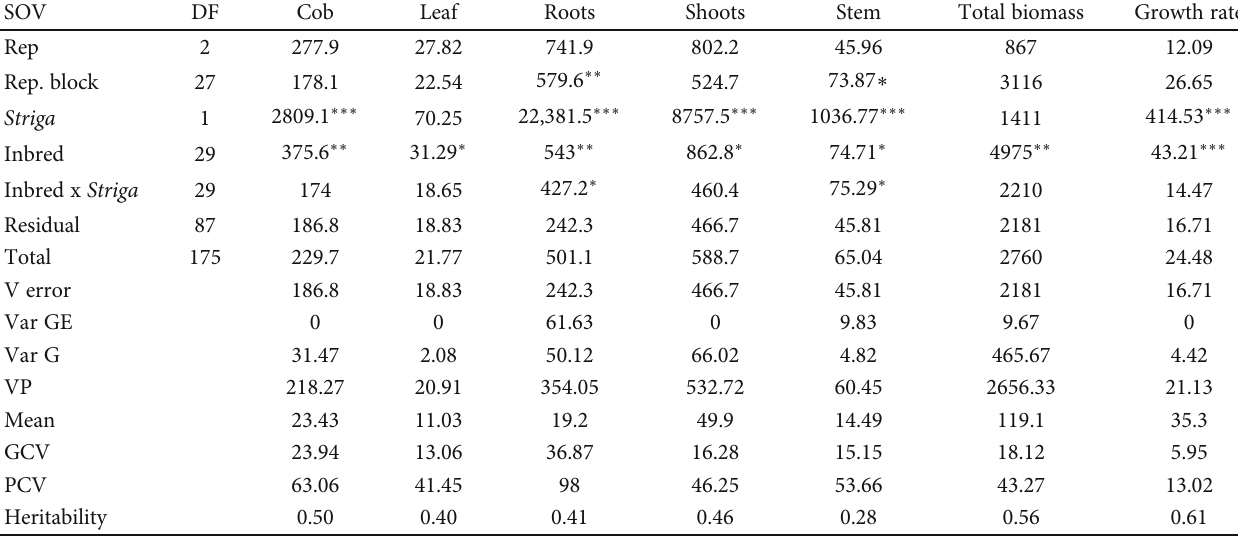
Table 5: Mean squares and heritability for morphological traits and growth rate under stress and non-stress conditions. SOV DF Cob Leaf Roots Shoots Stem Total biomass Rep Striga 2809.1 ∗∗∗